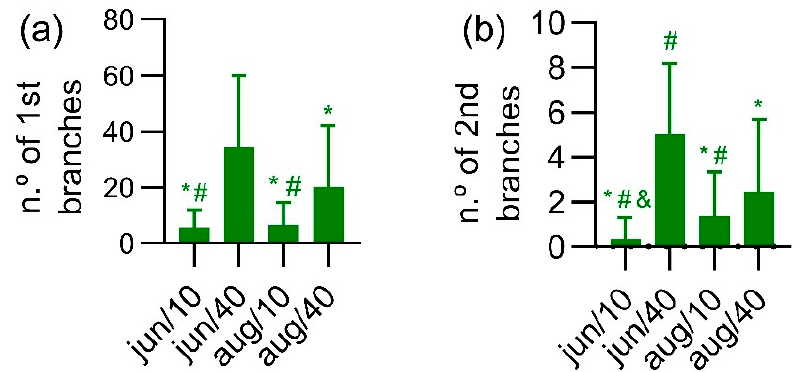
Figure 5. Effect of experimental conditions on the number of primary branches ( a ) and secondary branches ( b ) in the end of the vegetative growth period (2019/November). The data are represented as mean ± standard deviation of at least 80 measurements. * p < 0.05 compared to June/40, # p < 0.05 compared to August/40, and & p < 0.05 compared to Aug/10, according to the Kruskal–Wallis analysis followed by Dunn’s test.